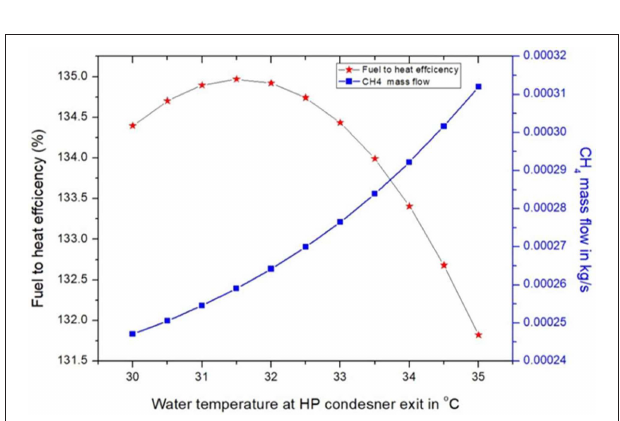
FIGURE 7 | Fuel-to-heat efficiency and CH4 mass flow rate when T w − exit − HP varies.